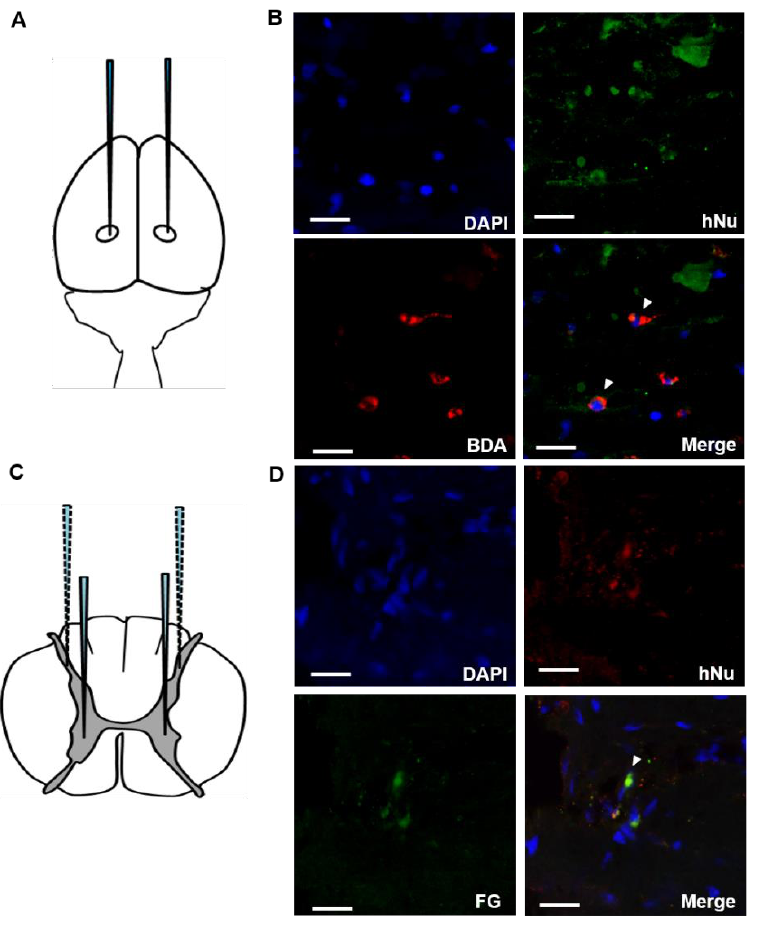
Figure 3. Tracing of transplanted F3.BDNF cells in vivo . ( A , C ) A schematic illustration showing bilateral injection of BDA in the motor cortex and bilateral injection of FG in the ventral horn and dorsal horn. ( B ) Two weeks later, BDA (red) was found in the F3.BDNF cells (green) that were identified with anti-hNu antibody. ( D ) One week later, F3.BDNF cells were co-localized with FG (green). Scale bars = 20 μm. Abbreviations: BDA, biotinylated dextran amines; FG, fluoro-gold; hNu, human nuclei antigen; DAPI, 4′, 6-diamidino-2-phenylindole.